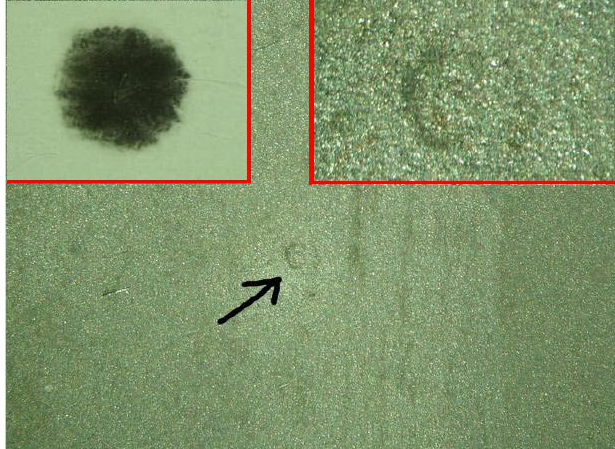
FIG. 6. (Color) Downstream surface of the target dosed with the ILC2 mode (target 2). The horizontal size of this picture corre- sponds to 10 mm. There is a small colored area that can be identified as the beam trace because a clear black spot was observed at the same position in the thermal paper as shown in the left-upper corner. An expanded image of this spot is super- imposed in the right-upper corner.